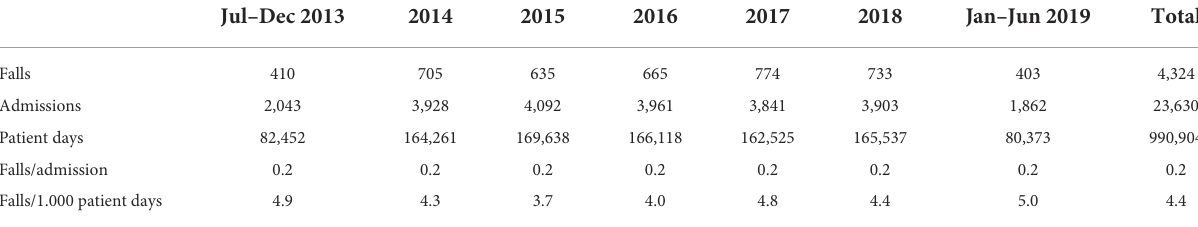
TABLE 1 Data on the prevalence of registered falls.